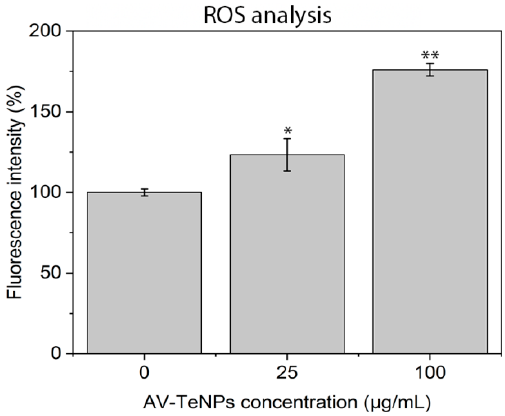
Figure 6. Reactive oxygen species (ROS) induced by AV-TeNPs in human melanoma cells experiments. A trend of the release of the species with the increase in AV-TeNPs concentration for the same timeframe is seen. N = 3. Data is represented as mean ± SD; * p < 0.05, ** p < 0.01 (compared to 0 concentration).